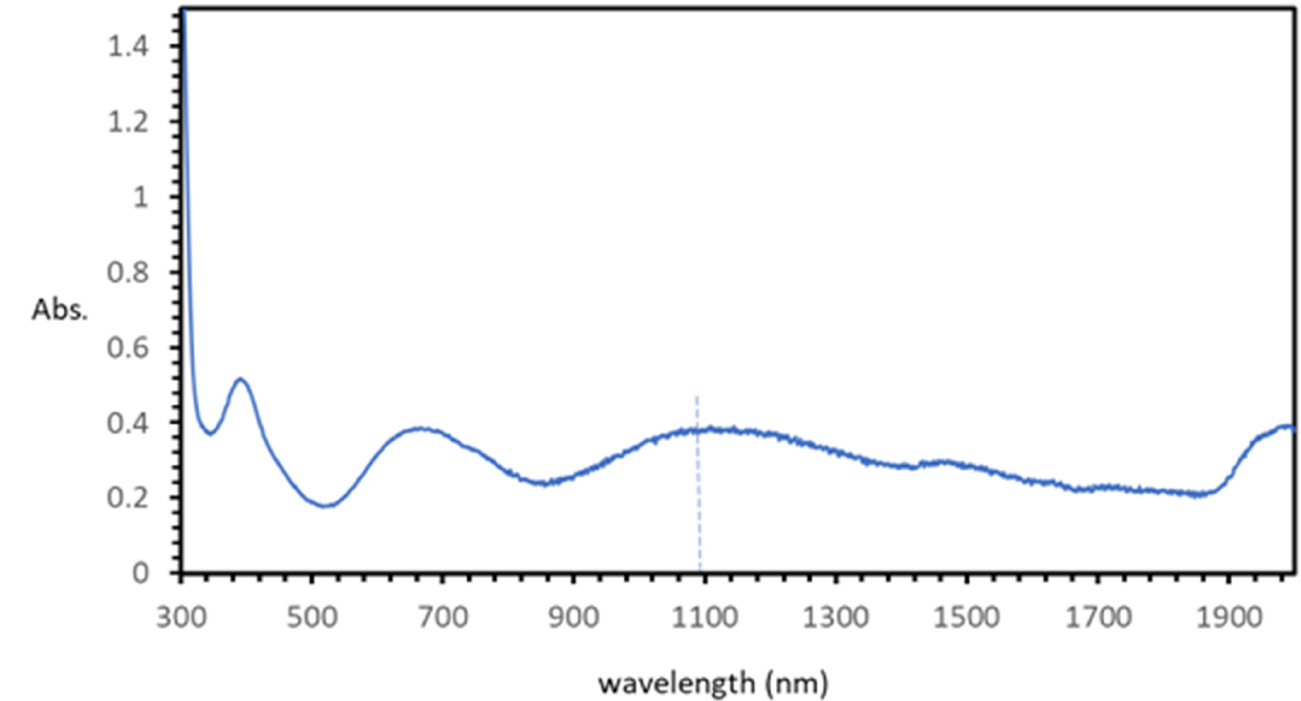
Figure 7. The electronic (diffuse reflectance) spectrum of compound 1 .